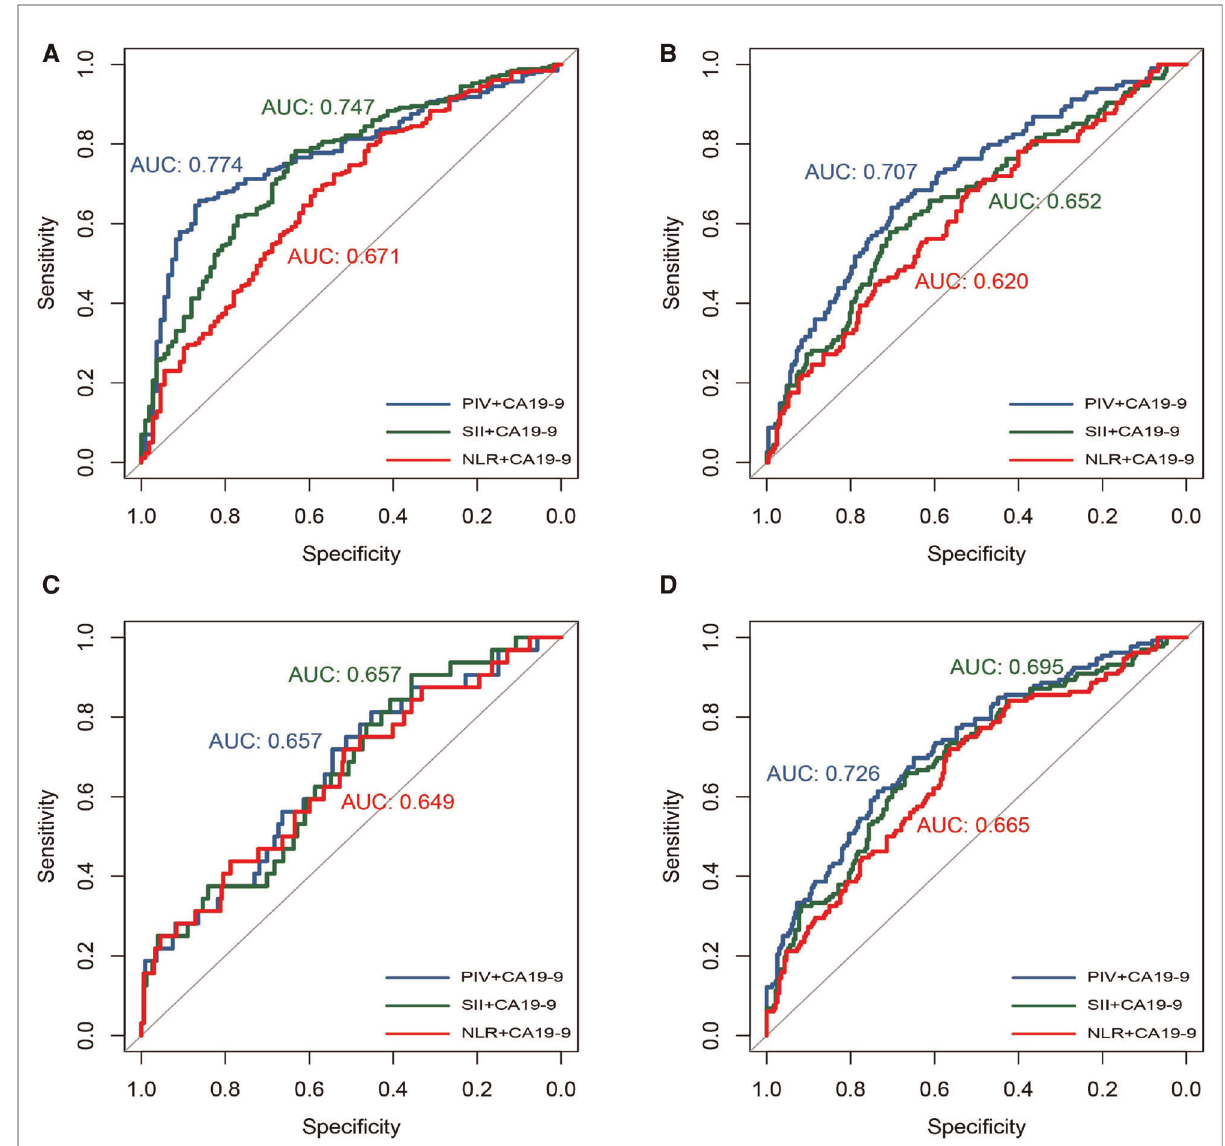
FIGURE 3 IIBS combined with CA19-9. Receiver operating curve analysis of T-stage ( A ); Receiver operating curve analysis of N-stage ( B ); Receiver operating curve analysis of M-stage ( C ); Receiver operating curve analysis of TNM-stage ( D